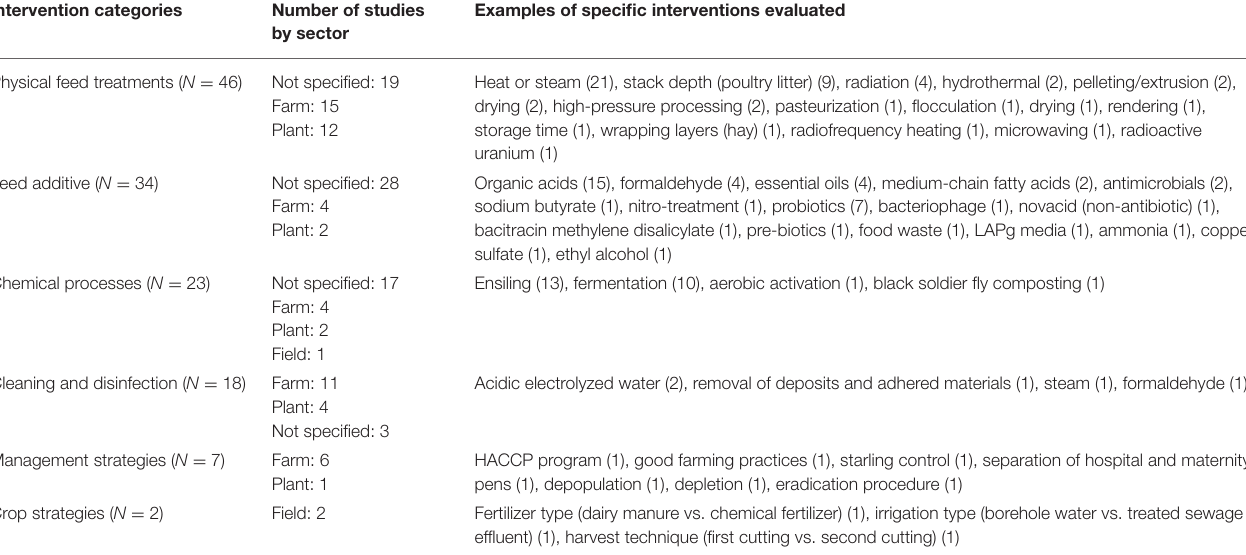
TABLE 5 | Summary of 120 intervention studies of Salmonella in animal feeds, feed equipment and feed environment. Intervention categories Number of studies Examples of specific interventions by sector